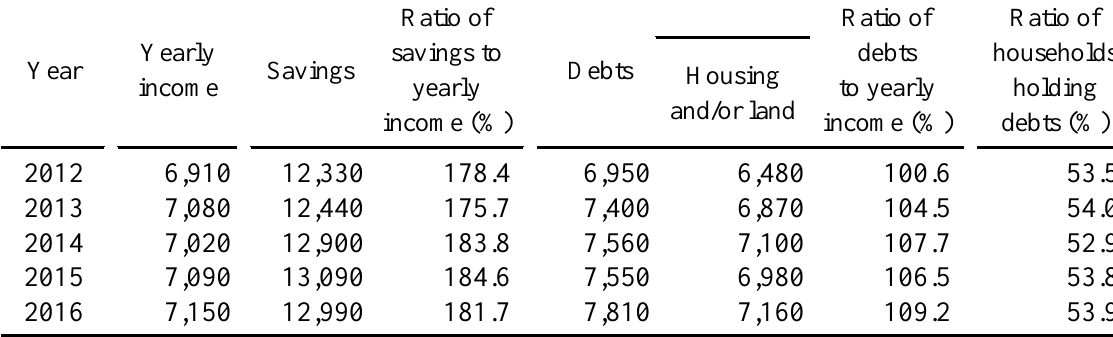
Table 13.3 Average Amount of Savings and Debts (Workers' households 1) )